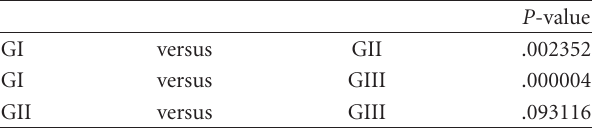
Figure 4: Occurrence of NUCKS in invasive ductal carcinoma, GII. The positive staining in this case was less frequent than that in the case shown in Figure 3. Some cells show also faint cytoplasmic parallel to nuclear reaction. ABC method. Magnification 200x, inset 40x. Table 2: Comparison of P -values between G groups.